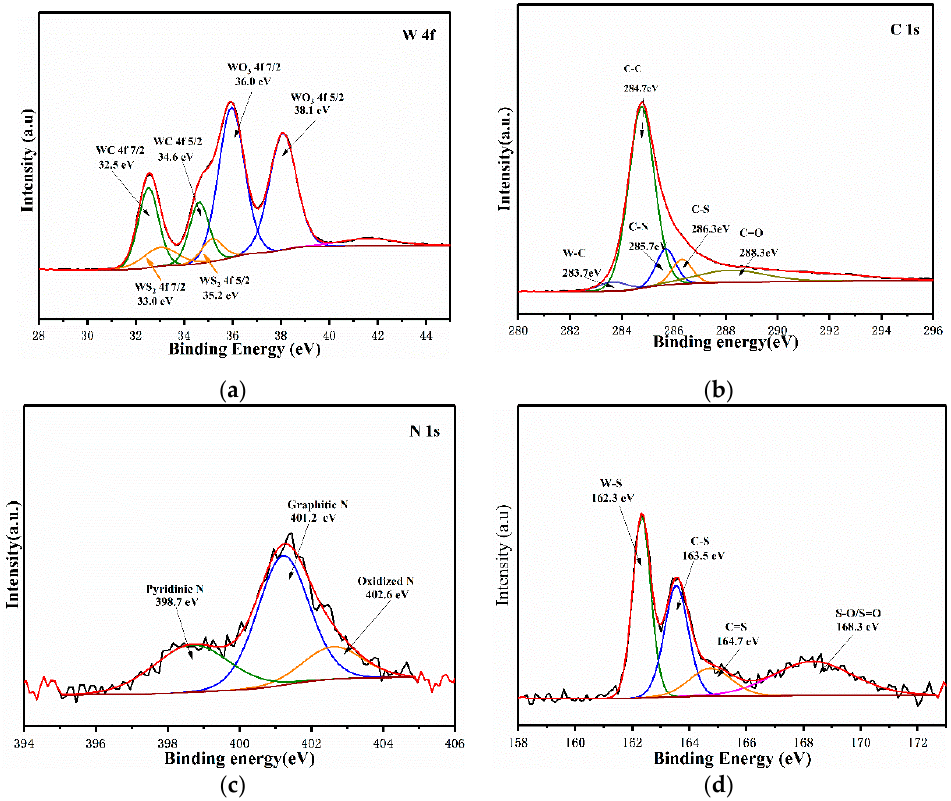
Figure 3. High-resolution XPS spectra of ( a ) W 4f, ( b ) C 1s, ( c ) N 1s, and ( d ) S 2p.